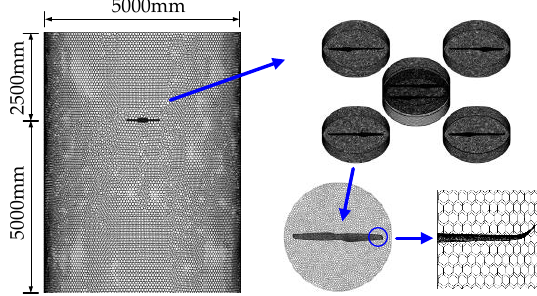
Figure 8. Computational grid.